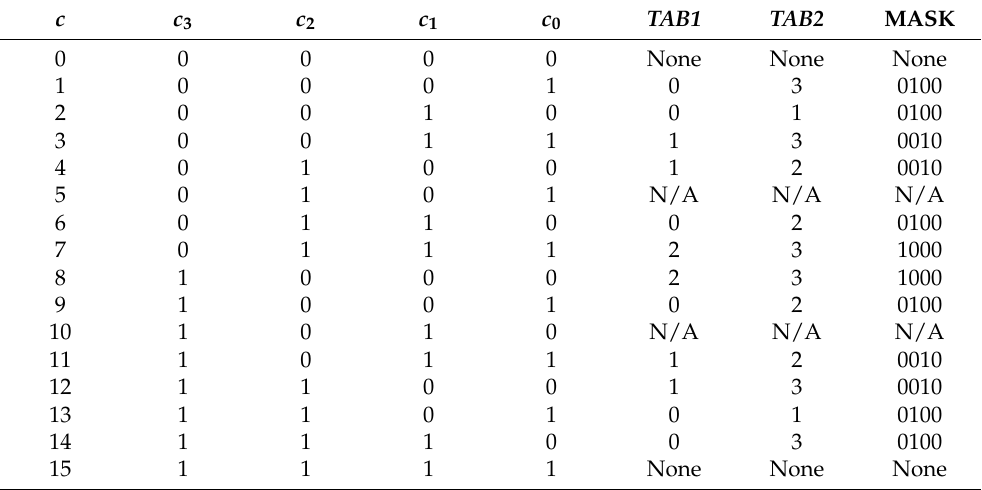
Table 1. Original values of the TAB-MASK